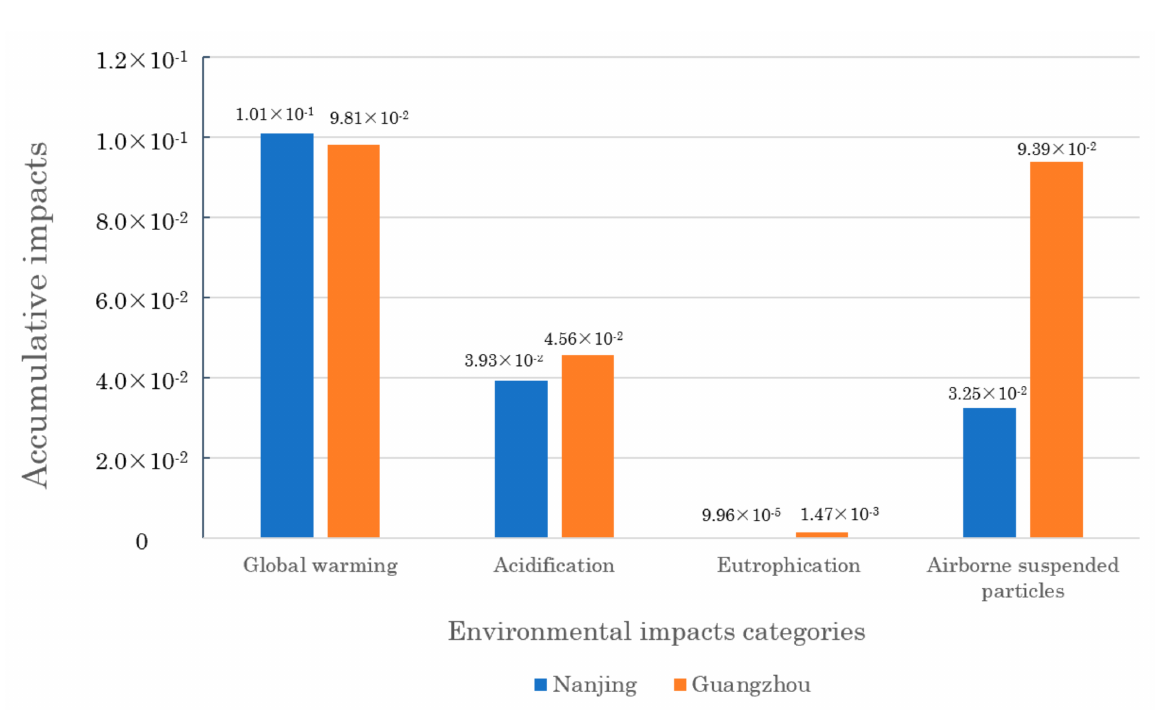
Figure 6. The accumulative impacts (per m 2 ) of different impact categories during